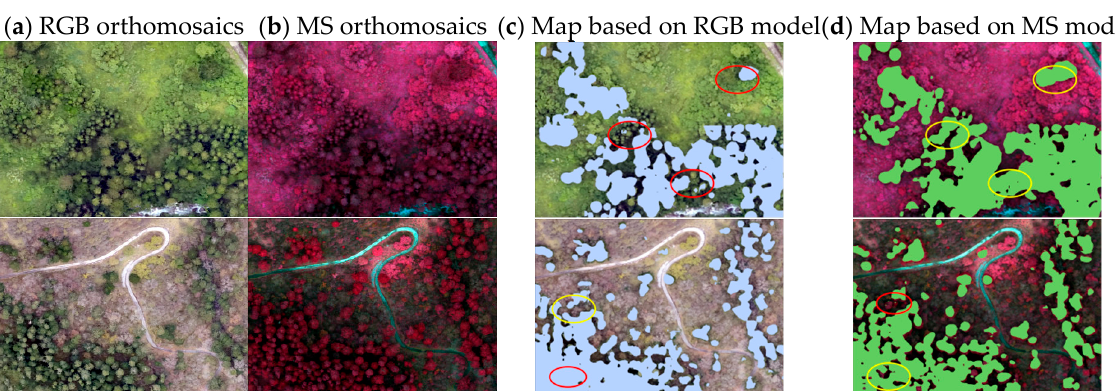
Figure 8. Faxon fir identification for different months. ( a ) UAV-based RGB orthomosaics, ( b ) manu- ally labeled reference data, ( c ) identification map based on the RGB model, ( d ) identification map based on the MS model. The yellow and red circles represent correct and incorrect identification results, respectively.